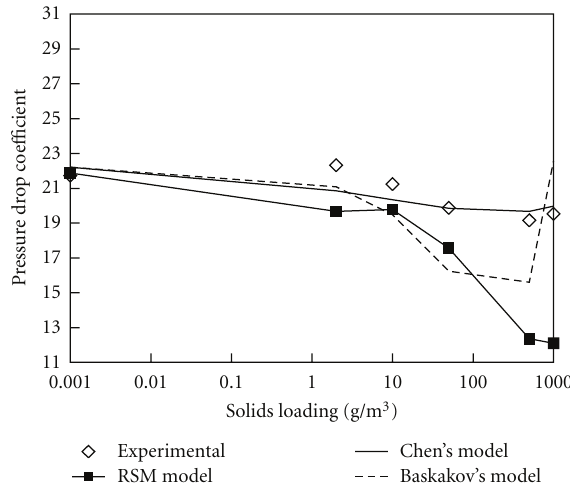
Figure 11: E ff ect of the particles loading on the pressure drop (geometry PV2 in Table